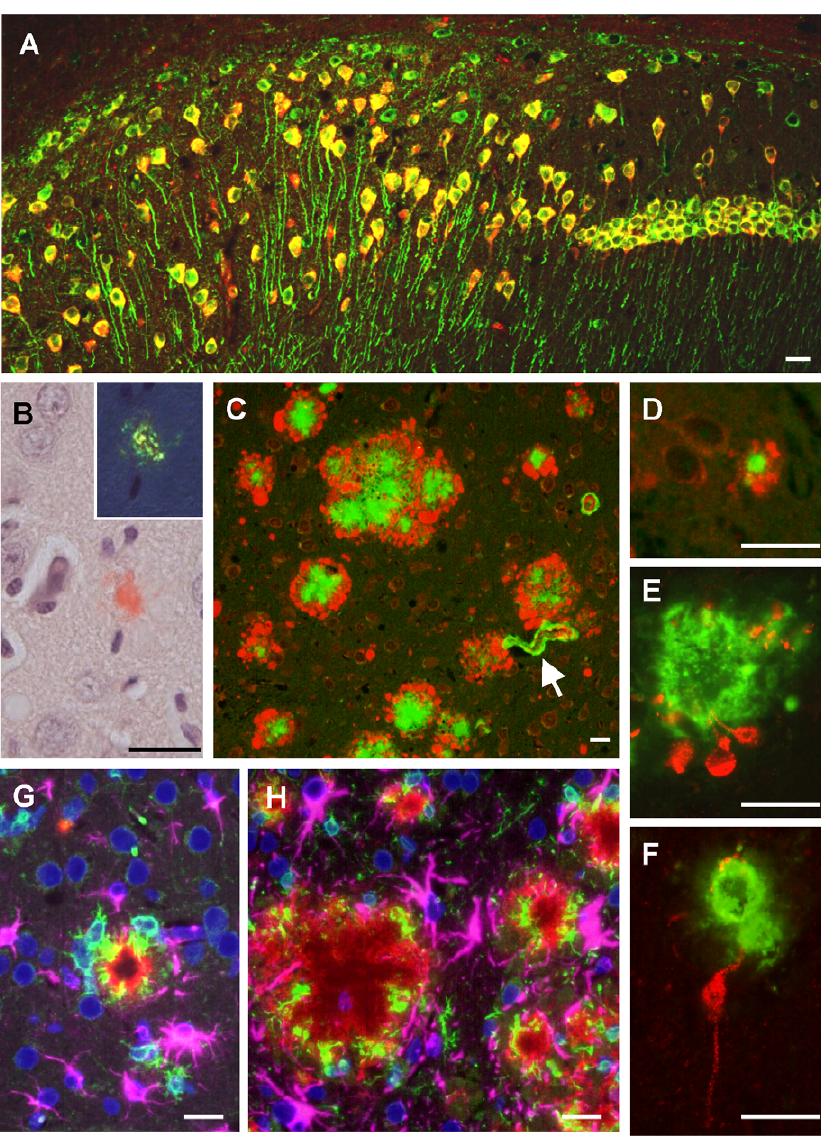
Figure 1. Amyloid pathology and glial inflammation in ARTE10 mouse brain. A , Double-immunofluorescent colocalization of the transgenic human APP ( red , human-specific antibody against the N-terminal ectodomain) with the neuron-specific somato-dendritic marker MAP2 ( green ) in the subiculum and the CA1 region of the hippocampus. The transgene is amply expressed in most ( . 80%) neurons ( yellow merge colour), whereas non-neuronal cells show no signals beyond background. B , Congo-red stained plaque core ( red ) in the frontal cortex of a hemizygous ARTE10 mouse at 5 months of age. The green bi-refringence in polarized light (inset) is diagnostic of amyloid. C, D , Thioflavin-S positive plaque cores ( green ), each encircled by a sphere (corona) of dilated, strongly ubiquitin-positive dystrophic neurites ( red ) in the subiculum of a homozygous ARTE10 mouse at 3 months of age (D) and in the frontal cortex of a 19 months old hemizygous mouse (C), the latter with concomitant amyloid angiopathy (arrow). E, F , AT8-positive hyperphosphorylated tau ( red ) in dystrophic neurites adjacent to plaque cores ( green : A b 40 and A b 42) in homozygous ARTE10 mice at 12 (E) and 8 (F) months of age. G, H , Triple-immunofluorescent demonstration of plaque-associated mixed glial inflammation: Activated microglia ( green , AIF1/Iba1) and reactive astroglia ( magenta , GFAP) colonizing the periphery of amyloid cores ( red : A b /6E10) in the subicula of a homozygous 5 months (G) and a hemizygous 13 months (H) old ARTE10 animal ( blue : nuclei/DAPI). Scale bar, 20 m m.